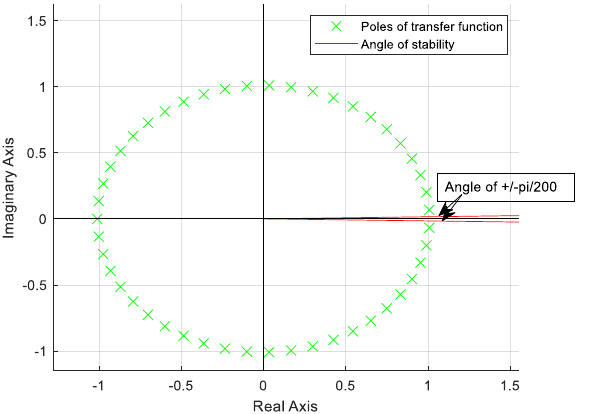
Figure 3. Poles of the commensurate order transfer function of fractional Kelvin–Voigt model. The equation of motion expressed with the fractional Kelvin-Voigt model is given as